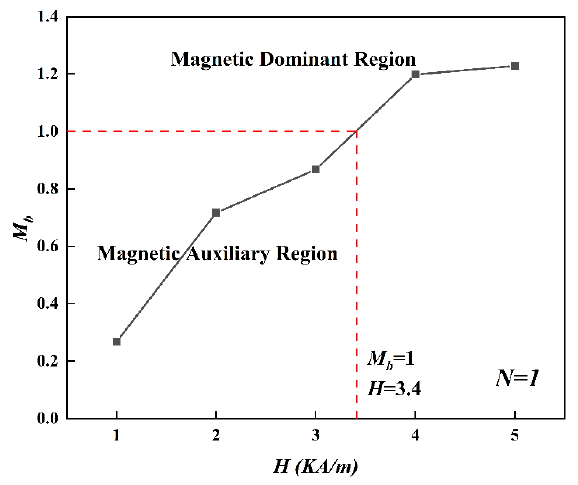
Figure 4. Curve of M b versus magnetic field strength H .